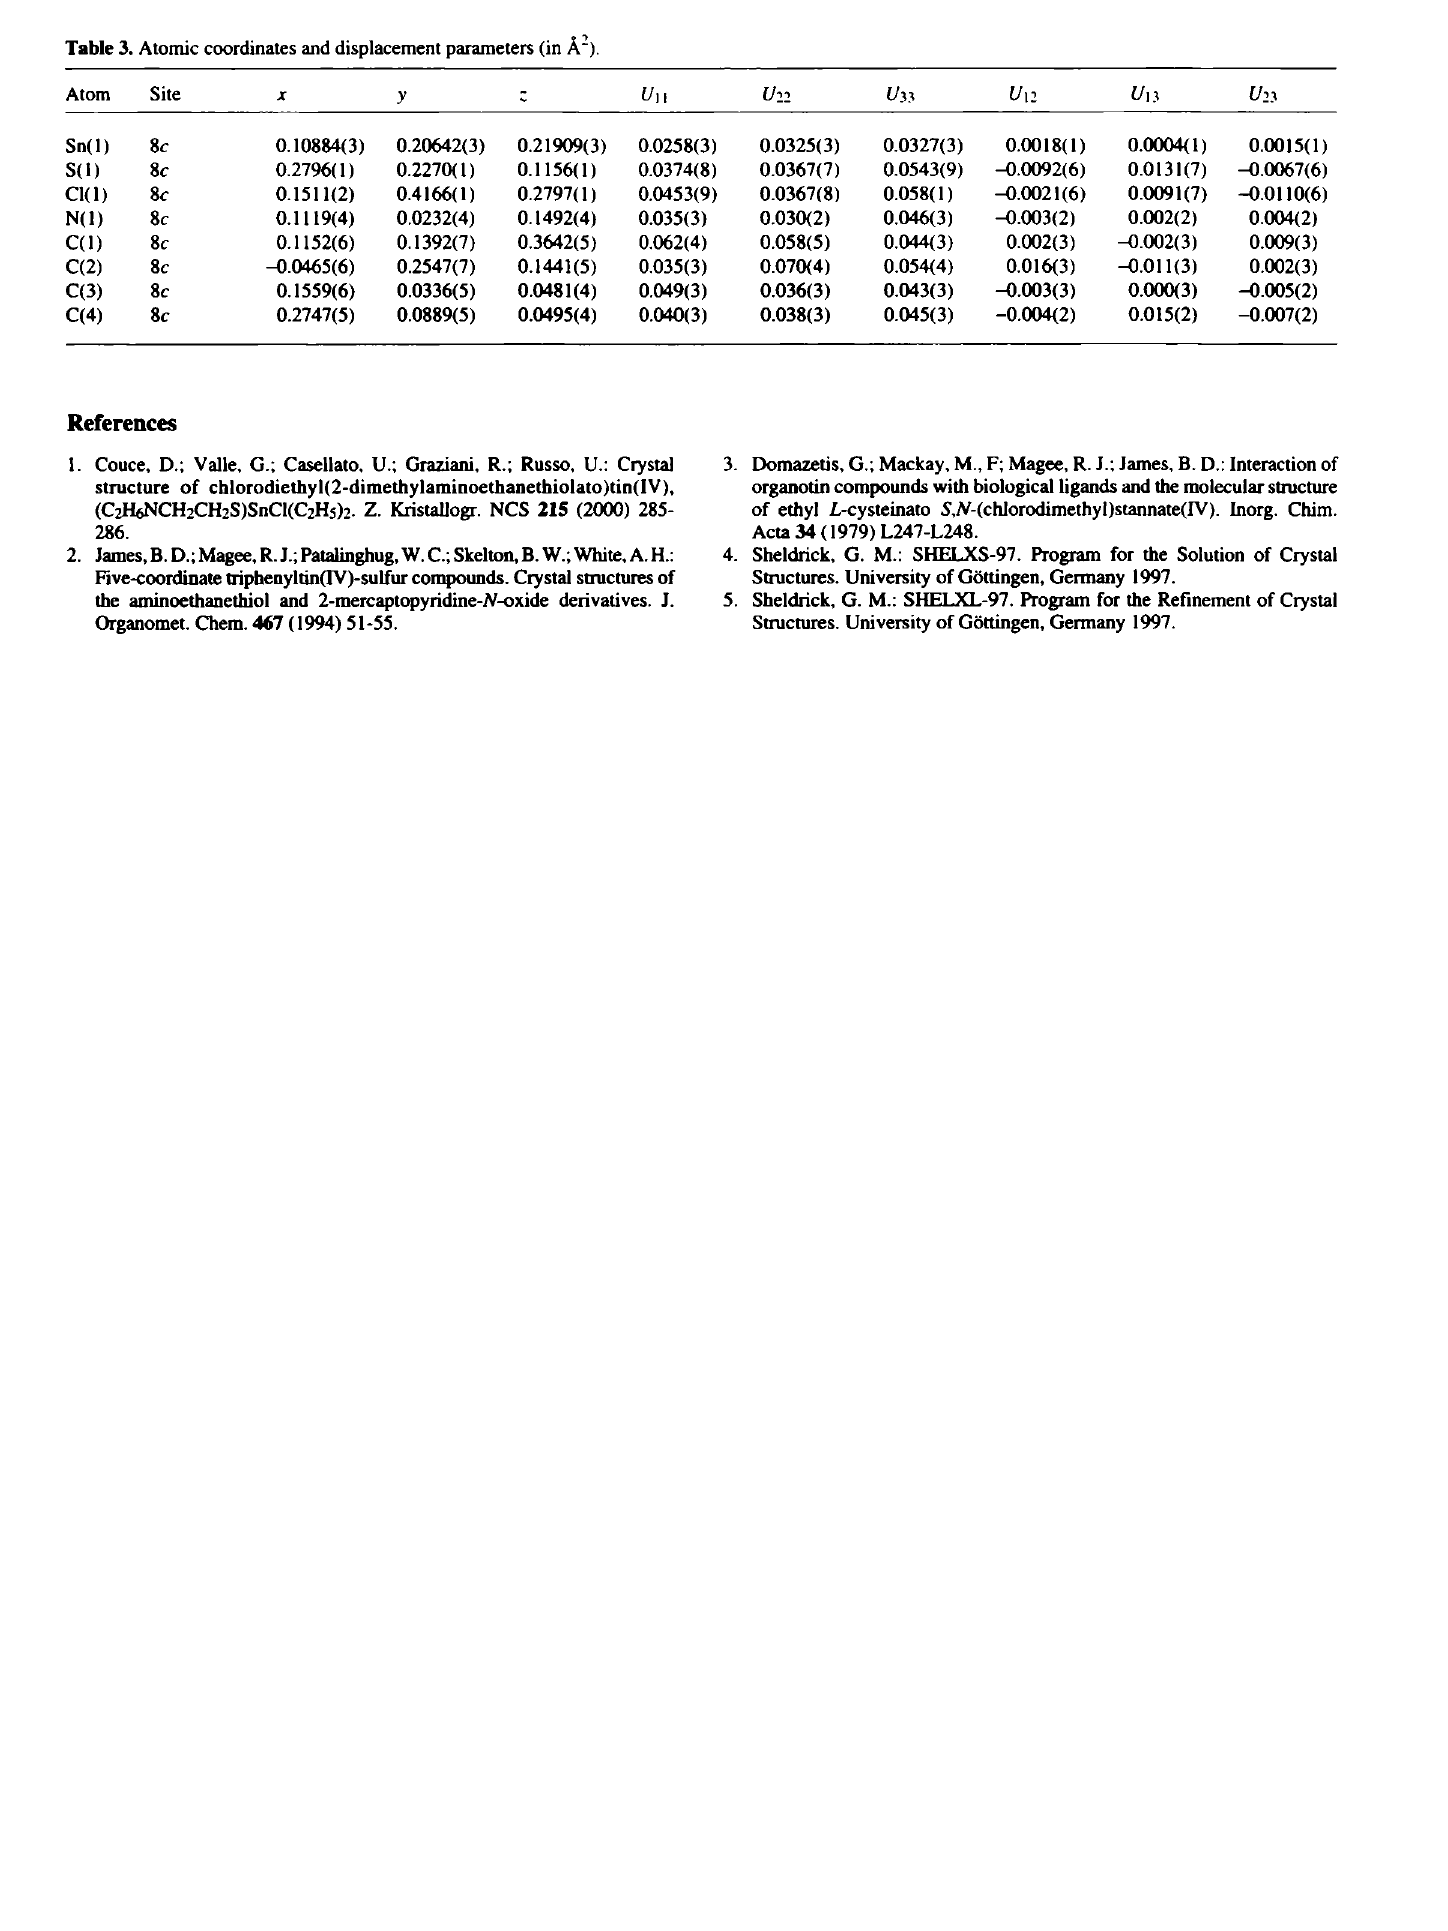
Table 3. Atomic coordinates and displacement parameters (in Â 2 ).